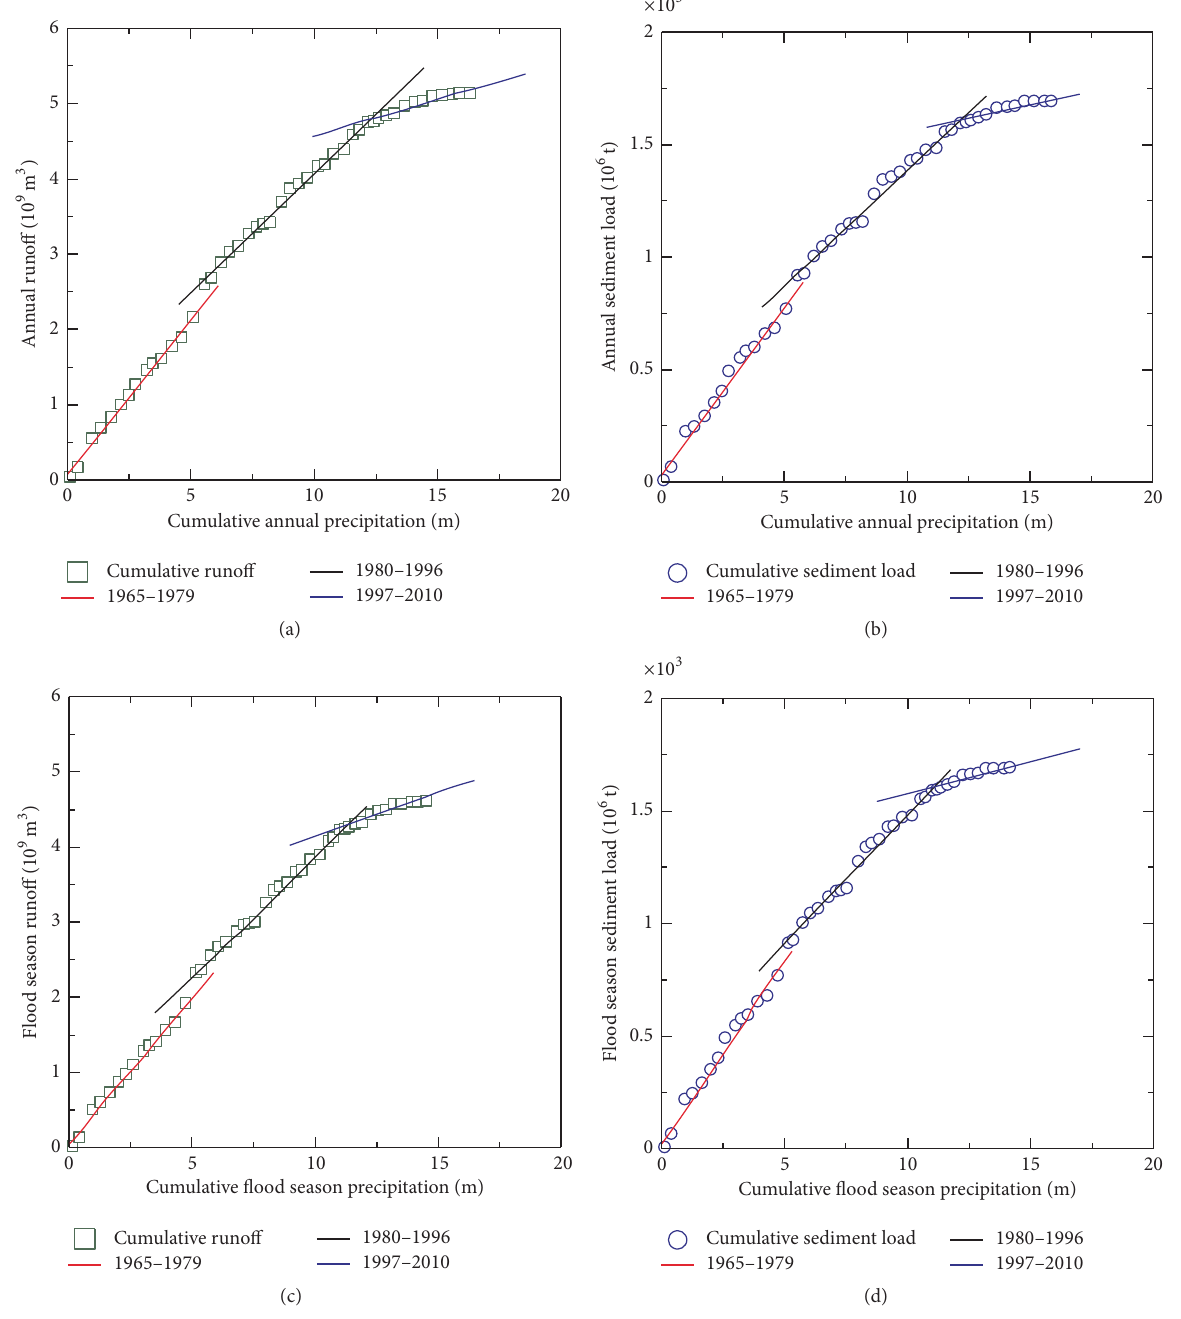
Figure 7: Double mass curve analysis of runoff-precipitation (a, c) and sediment load-precipitation (b, d) at annual and flood season scale.